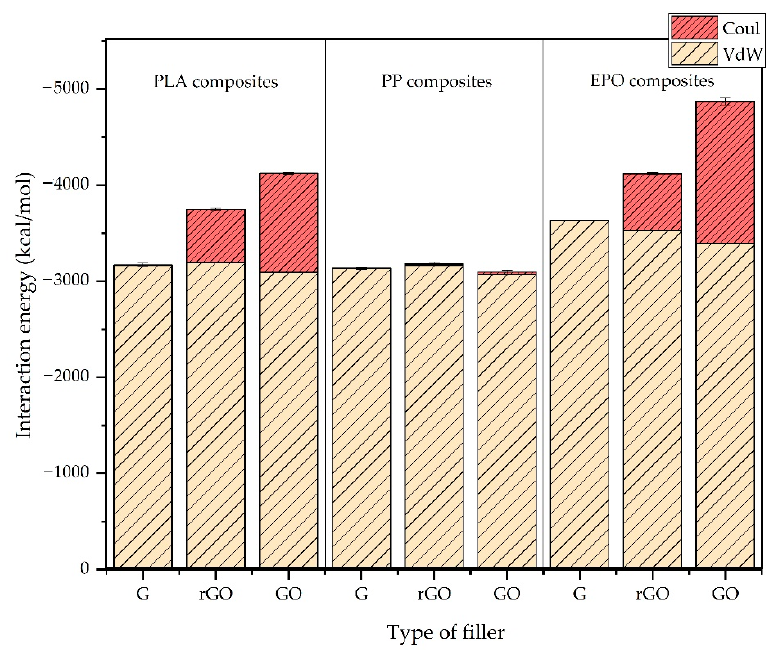
Figure 6. Comparison of interaction energy between the different graphene–polymer composite systems (G: neat graphene; GO: graphene oxide; rGO: reduced graphene oxide). systems (G: neat graphene; GO: graphene oxide; rGO: reduced graphene oxide).